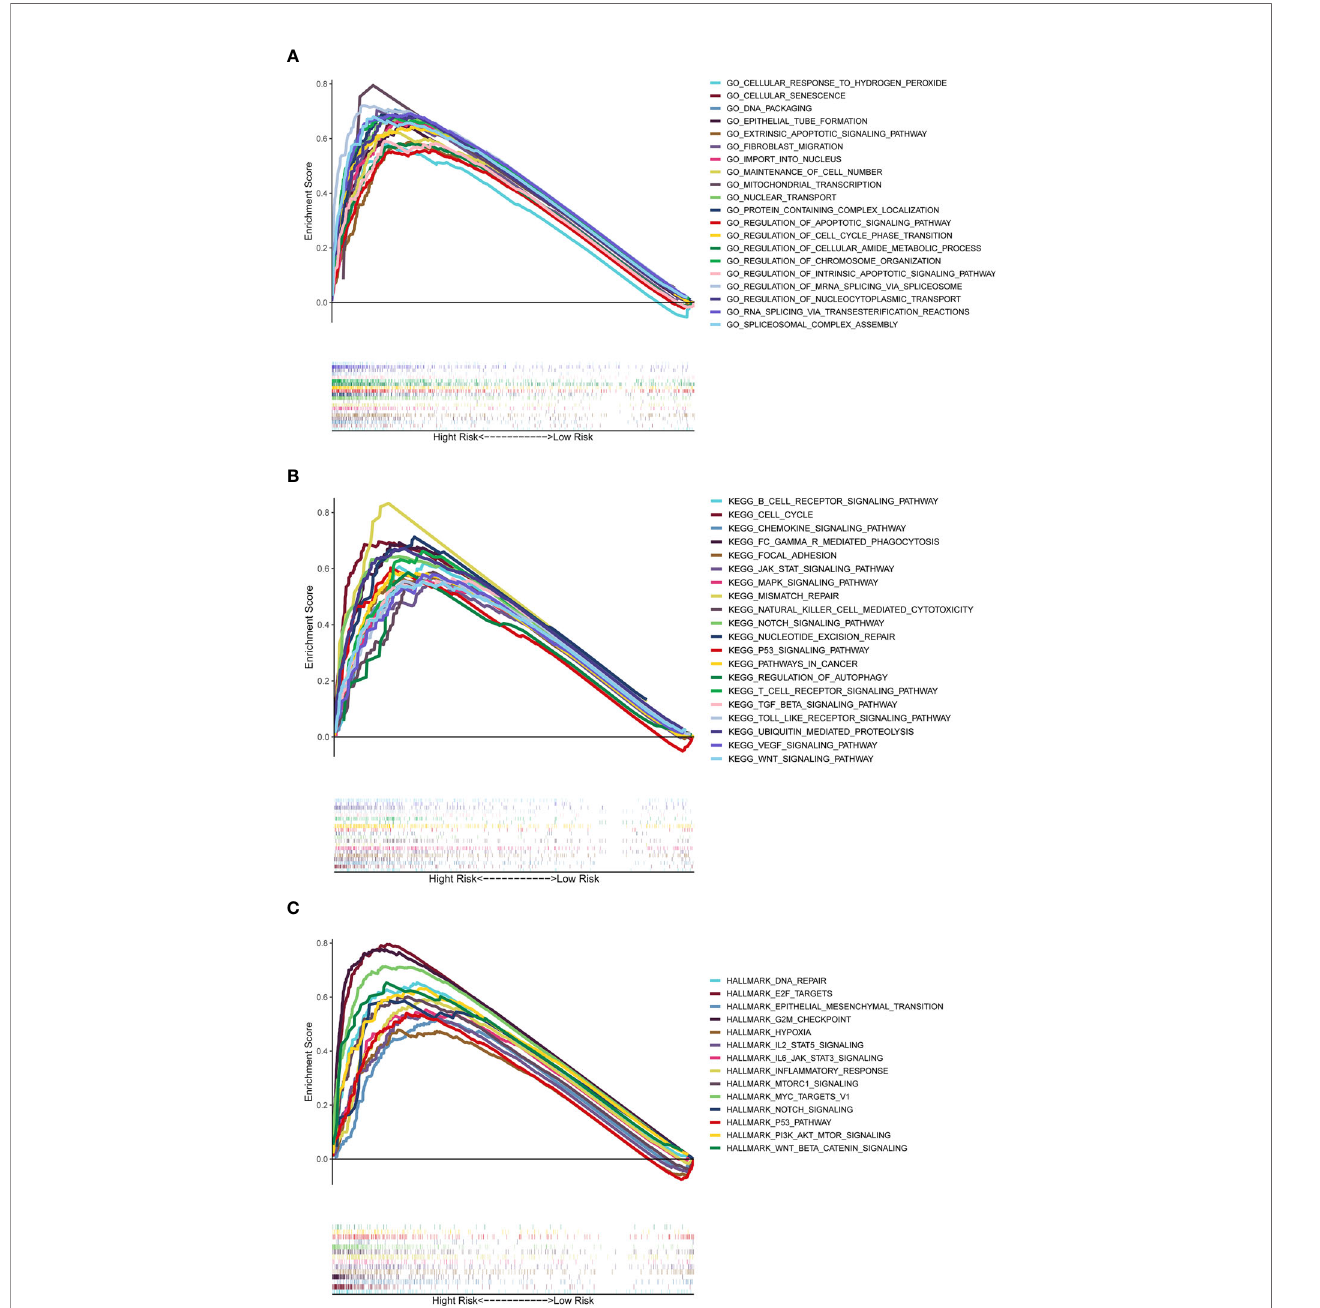
FIGURE 8 | Gene set enrichment analysis of Biological functions and pathways. (A) GO, Gene Ontology. (B) KEGG, Kyoto Encyclopedia of Genes and Genomes. (C) Hallmark gene